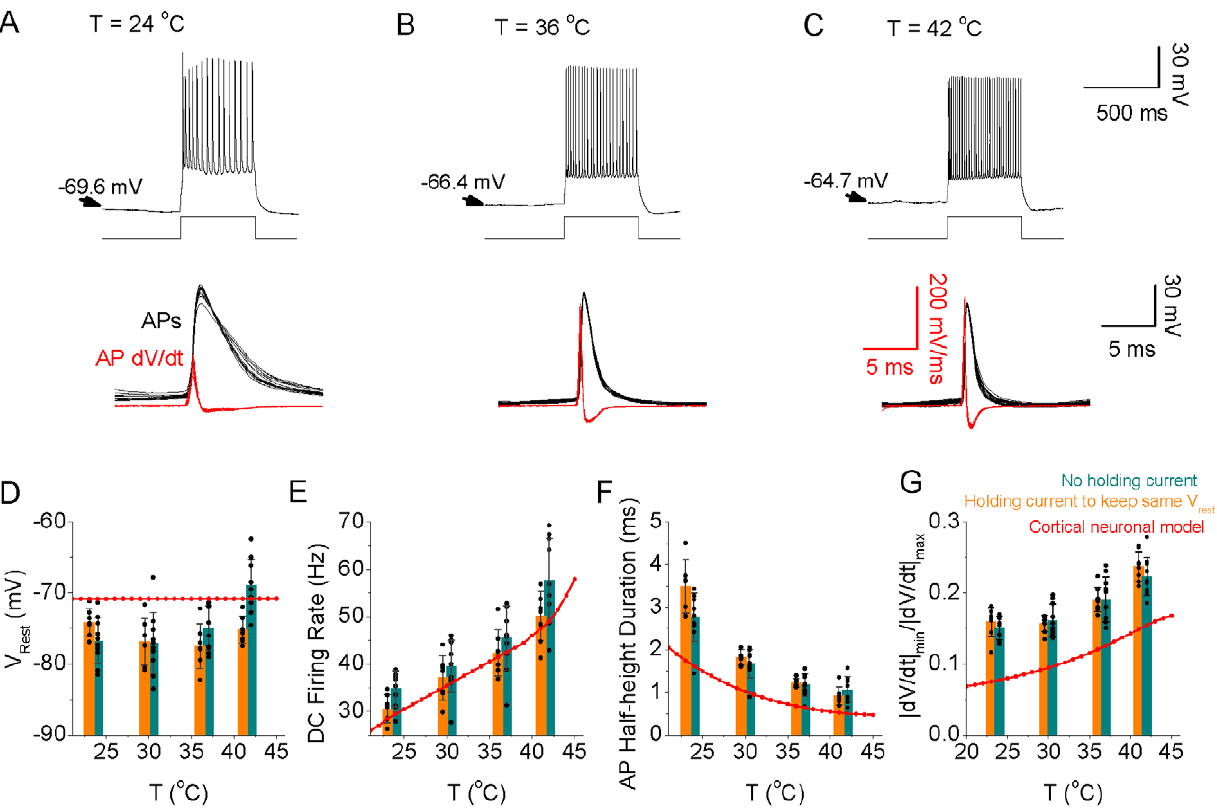
Figure 9. Increasing temperature increases neuronal responsiveness in layer 2/3 entorhinal cortical pyramidal cells. Intracellular recordings from a layer 2/3 pyramidal neuron to a DC input (150 pA, 500 ms duration) at a temperature of 24, 36, and 42 u C respectively (A–C). Note that the neuron not only increases its firing rate, but also decrease its spike duration, to the current pulse with an increase in temperature. The dV/dt of action potentials shows a gradual increase of the peak rate of rise and fall with increases in temperature. D–G. Bar graphs illustrating that increasing temperature results in a depolarization of the membrane potential (cyan bars), an increase in spike rate, a decrease in single spike duration, an increase in the ratio of the absolute minimal dV/dt to maximal dV/dt, respectively. Similar effects were obtained when the depolarization of the membrane potential that was particularly prominent at 42 u C was kept relatively negated by adjusting the holding current (orange bars). As a comparison, the cortical model results for a DC input (1 6 10 2 2 pA/ m m 2 , 500 ms duration) are represented by the red